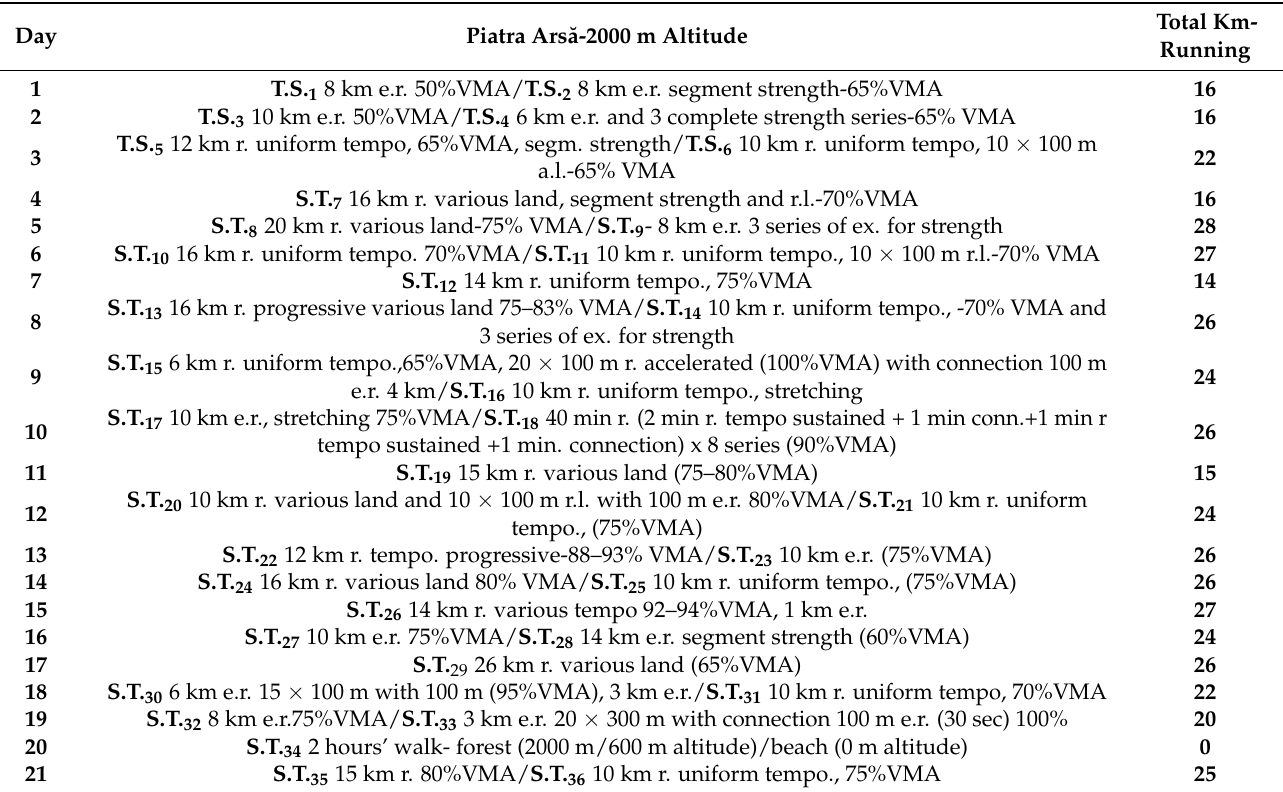
Table 2. Training program: Piatra Ars ă (2000